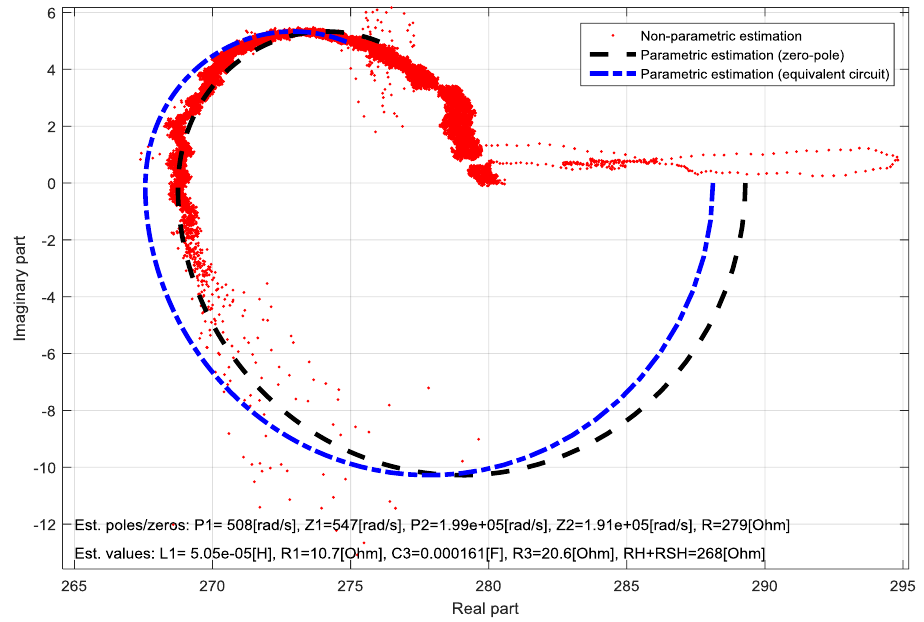
Figure 7. Comparison of the non-parametric and parametric TF identifications of a three-layer half-textile DSSC in Nyquist-diagram.